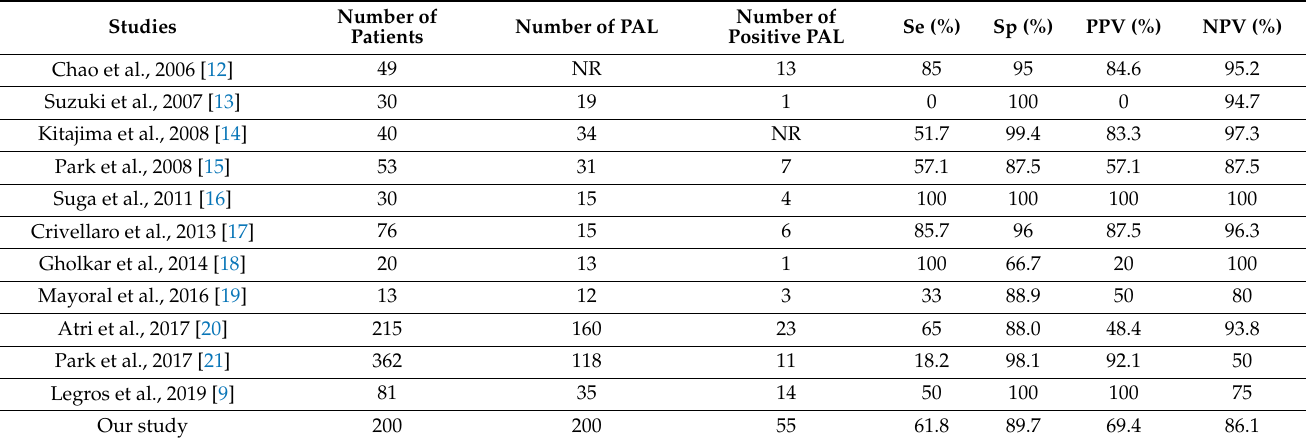
Table 4. Main studies evaluating the performance of FDG-PET/CT at the para-aortic